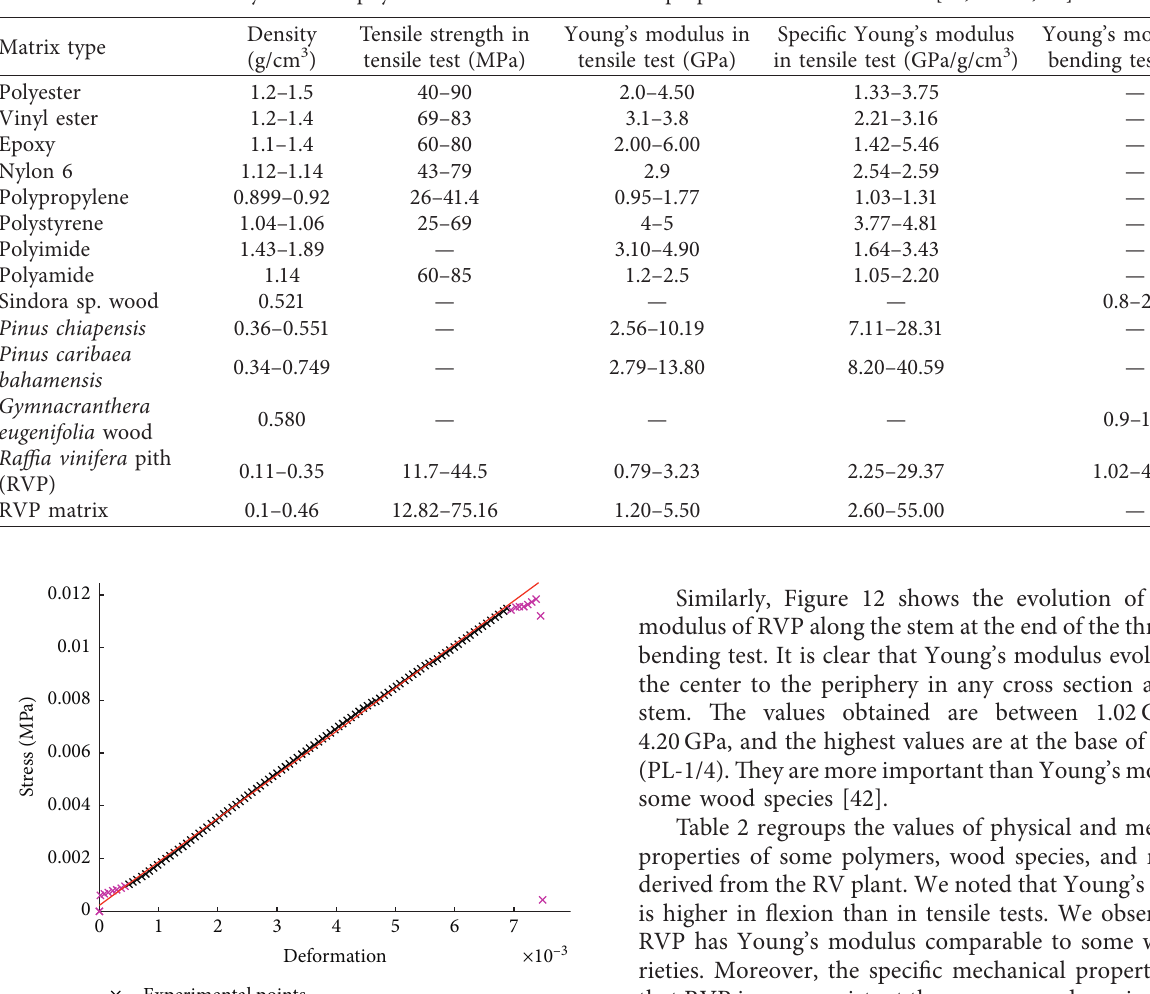
Figure 7: Evolution of the bulk density of the matrix from the RVP along the stem. Table 2: Synthesis of physicochemical and mechanical properties of some materials [38, 40–42, 45].